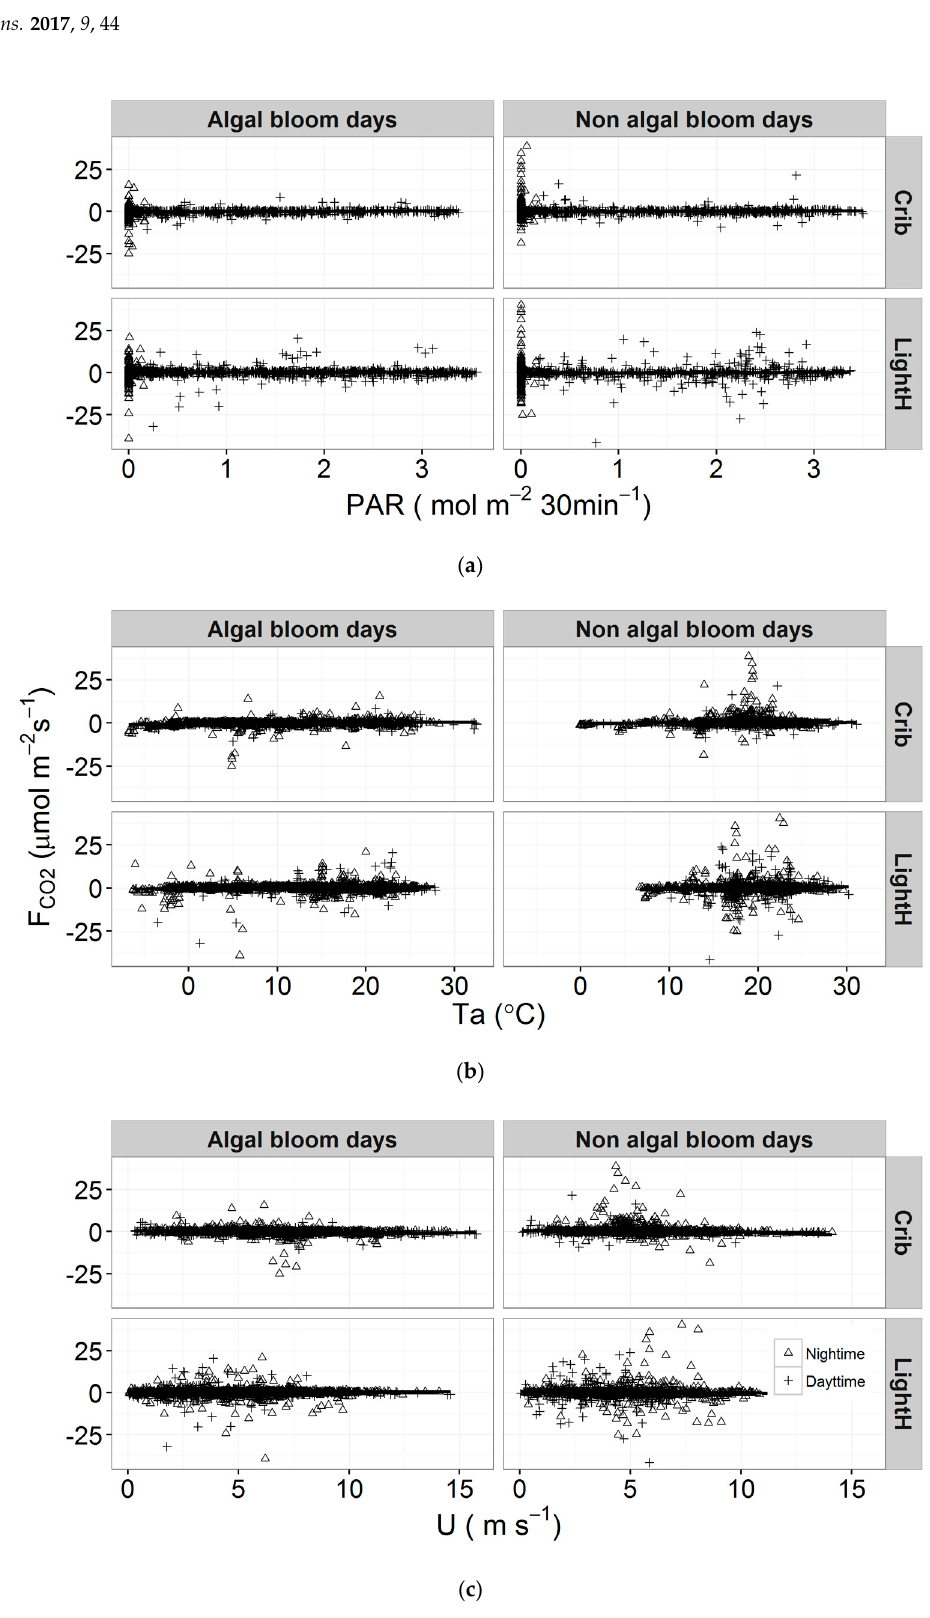
Figure 5. Changes in 30-min F CO2 with photosynthetically active radiation (PAR) ( a ) air temperature (Ta) ( b ), and wind speed (U) ( c ) during algal bloom days ( ≥ 10 µg/L) and non-algal bloom days (<10 µg/L) and changes at the LightH site and the Crib site. There appeared no obvious linear/nonlinear relationships between F CO2 and the three meteorological variable during both day and night periods. Sixty-five and sixty-one algal bloom days were observed for the LightH and Crib sites, respectively.